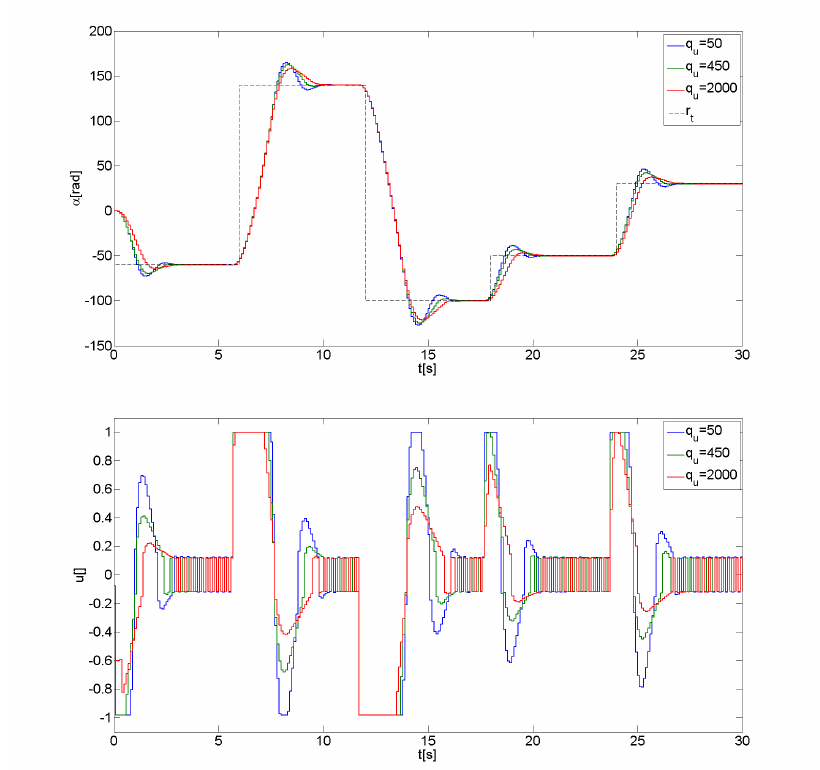
Figure 5. A proper choice of q u for N u = N y = 3, T S =